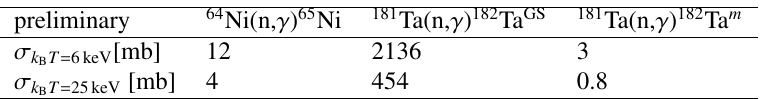
Table 1. Preliminary neutron capture cross sections of the reactions 64 Ni(n, γ ) 65 Ni, 181 Ta(n, γ ) 182 Ta and